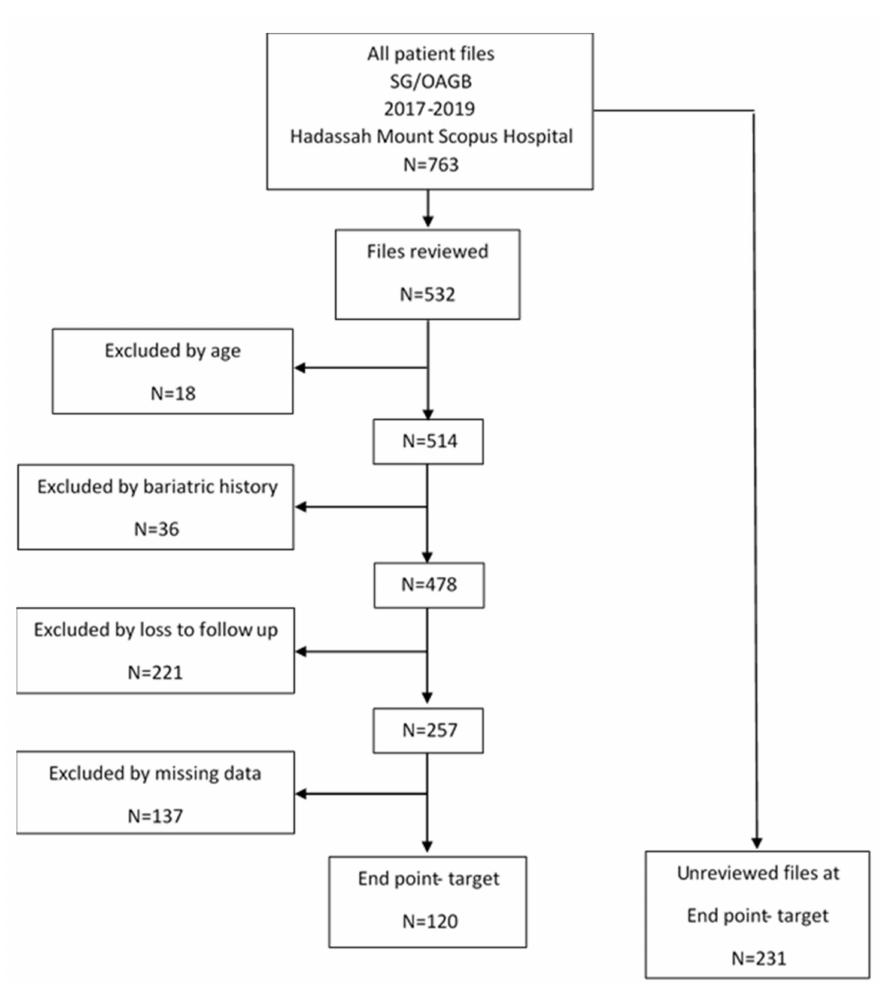
Figure 1. Flowchart of patient selection portfolios to create the study database.